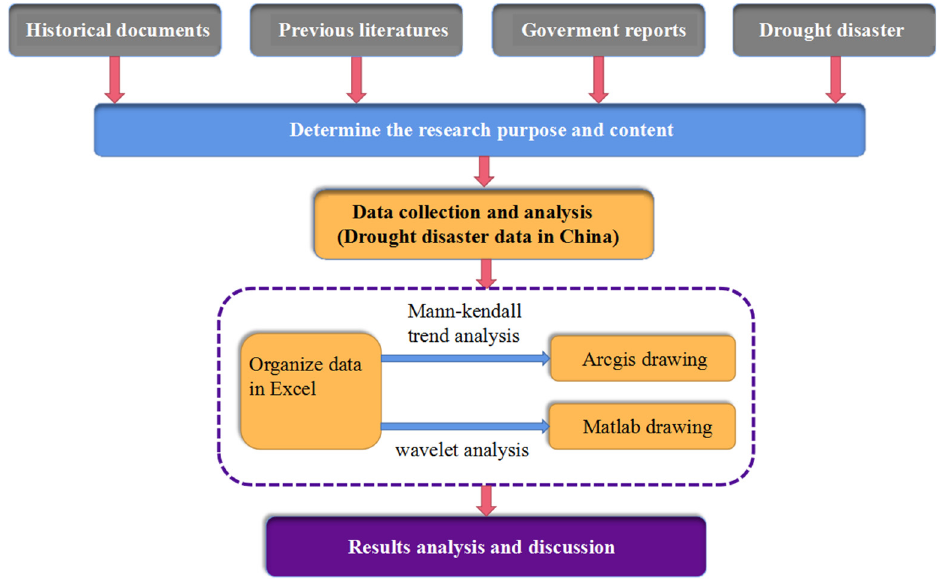
Figure 2. Research framework of this study.